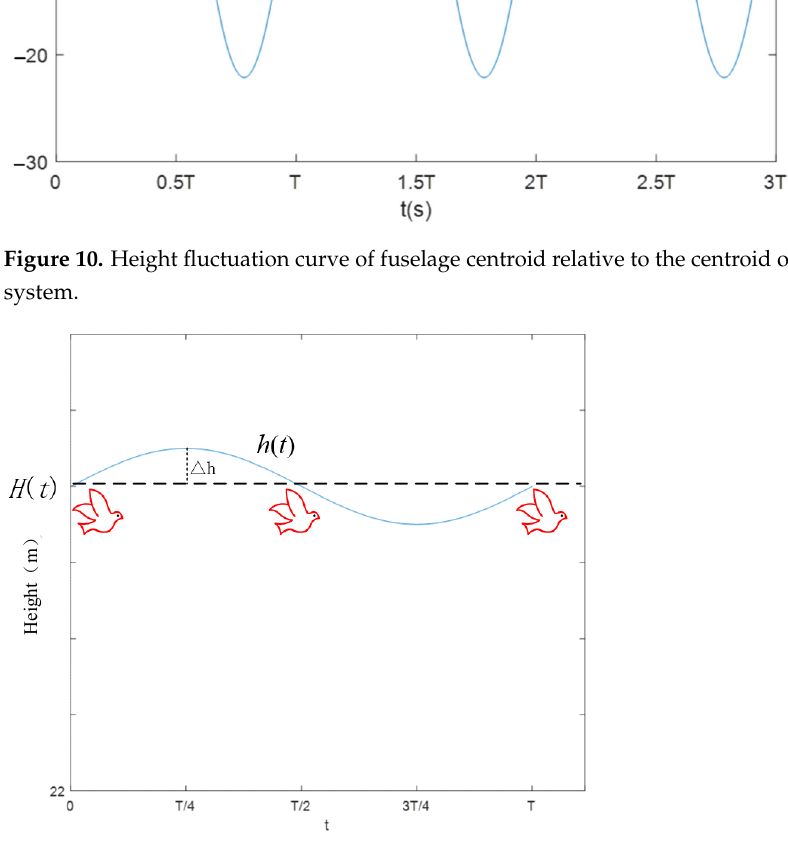
Figure 12. Centroid height variation curve and periodic equivalent height during maneuvering flight. 3.3. Attitude Solution Based on Explicit Complementary Filtering Because the traditional complementary filtering algorithm is not suitable for the flap- ping wing system with severe vibration [9,27], a more widely practical display comple- mentary filtering algorithm was used to solve the attitude of the “Phoenix” flapping wing robot. It combines the data of the accelerometer, magnetometer and gyroscope, and uses the estimation error of the accelerometer and the magnetometer to a certain constant vec- tor to correct the zero-drift change of the three axes of the gyroscope so that the angular velocity data is closer to the real value, thereby suppressing the attitude divergent.